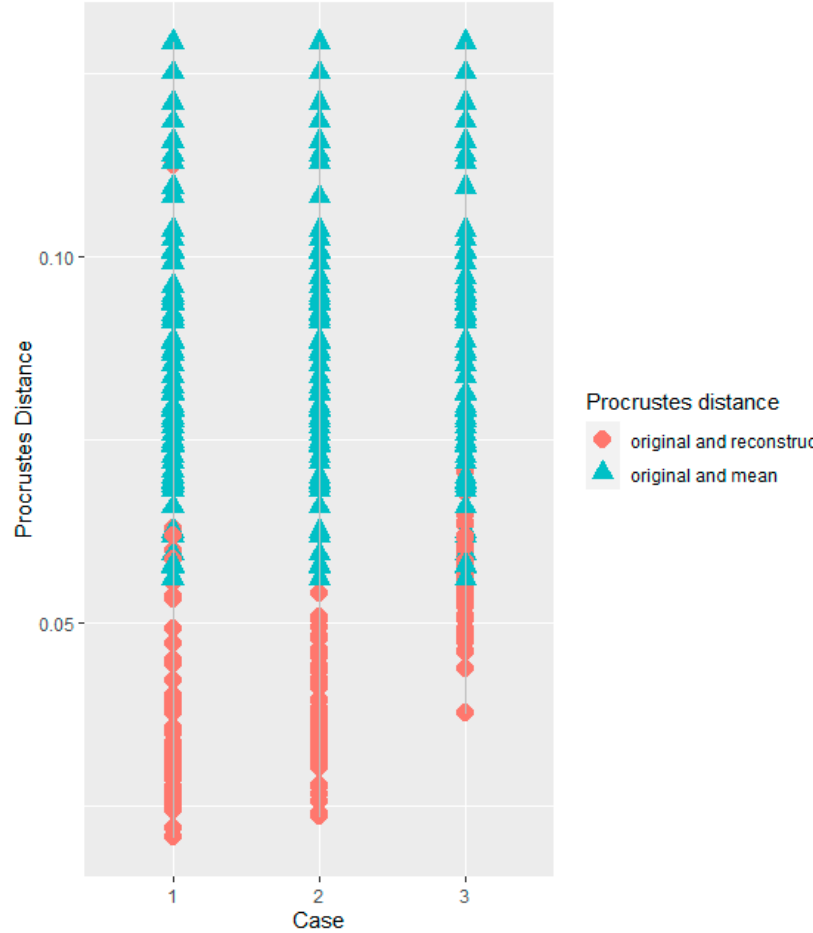
Figure 2. Scatterplot showing the predictive power of the reconstruction method for Cases 1–3 in the complete sample. Red dots indicate the Procrustes distances between the true and predicted landmark coordinates. Light-blue triangles indicate the Procrustes distances between the landmark coordinates of the original zygomatic and the mean configuration of the reference sample.